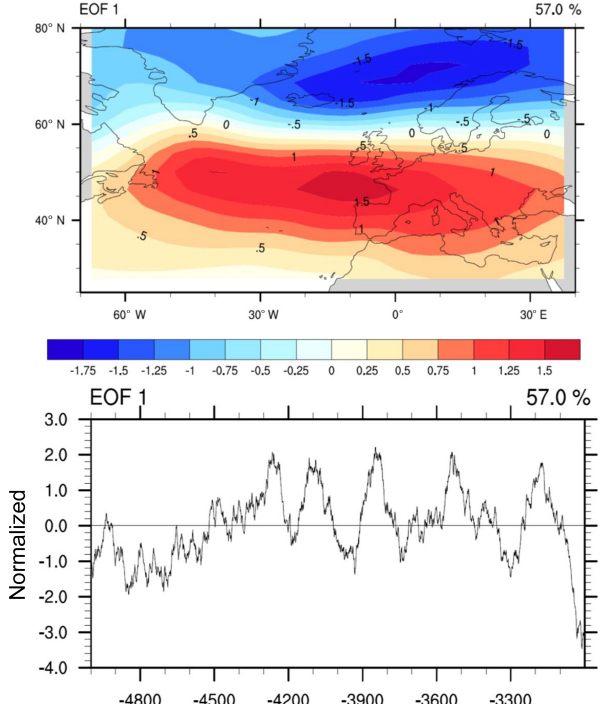
Figure 7. Standardized first leading mode of the EOF of annual mean geopotential height at 200hPa during the period of 5.0 to 3.0ka derived from the TraCE-ALL run, after the application of a 101-year running mean. The spatial distribution is shown in the top panel, and the time series is shown in the bottom panel. Only this mode passed the North test for the EOF.